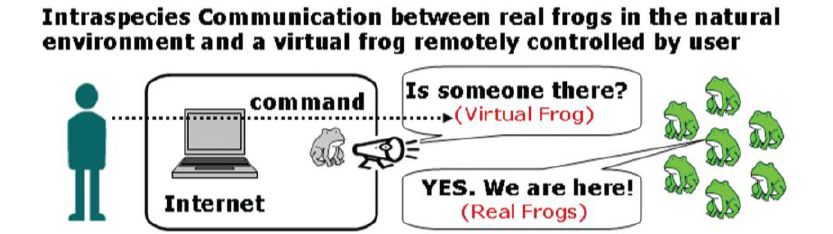
Figure 9. Intraspecies communication in mixed reality. Copyright 2009 Hiroki Kobayashi, with permission from